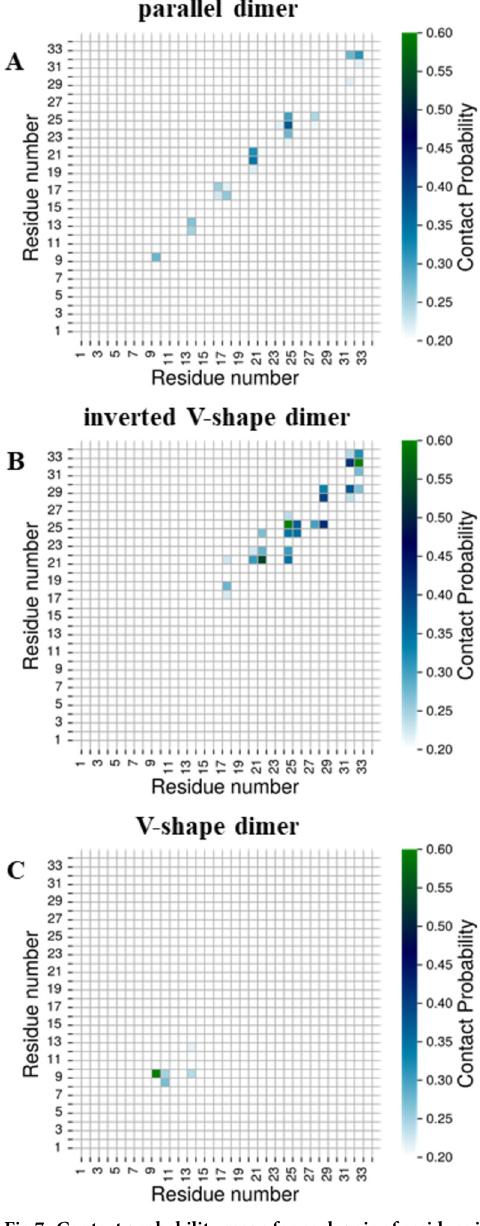
Fig 7. Contact probability maps for each pair of residues in the SP-C homodimers averaged over all homodimers belonging to the given dimer topology. Contact probabilities equal to one correspond to the situation where given residues are in contact in all homodimers belonging to this cluster topology. Two residues were considered to be in contact, if any of their beads were closer than 6 Å . Only contact probabilities higher than 0.20 are shown for